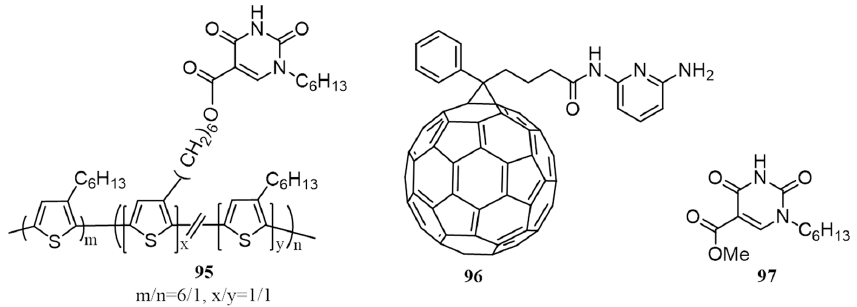
Figure 32. Chemical structures of the functionalized block copolymer ( 95 ), 2,6-diaminopyridine